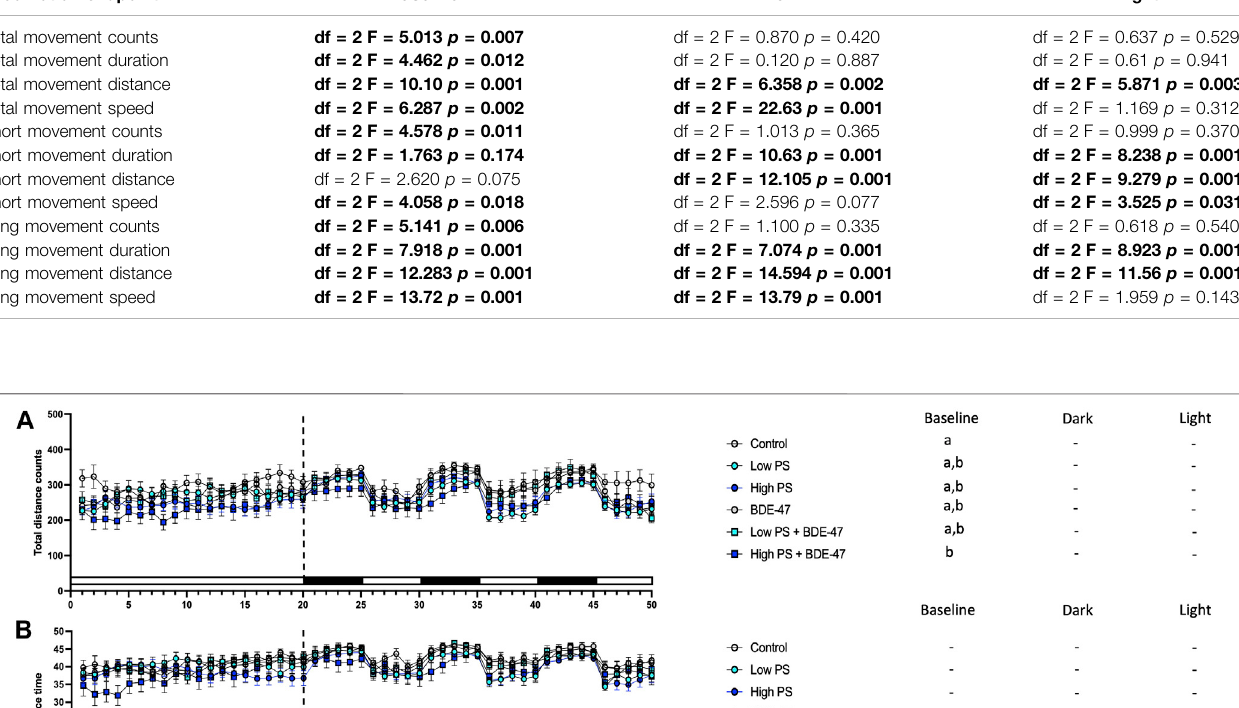
TABLE 3 | Cohort effects in repeated measurement ANOVA analyses on locomotion assay endpoints. Bold font indicates signi fi cance at a p < 0.05 threshold. Locomotion endpoint